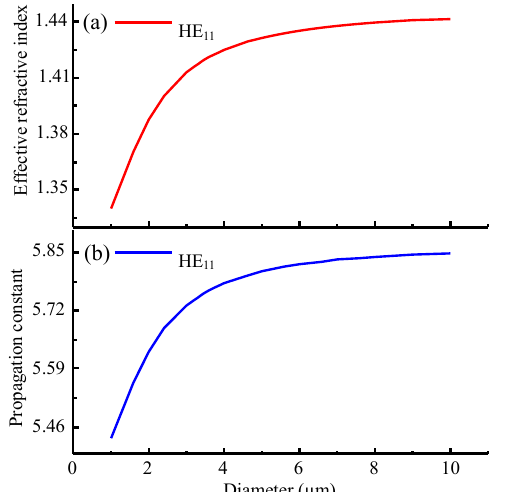
Fig. 3 Numerical results: (a) effective refractive index and (b) propagation constant.